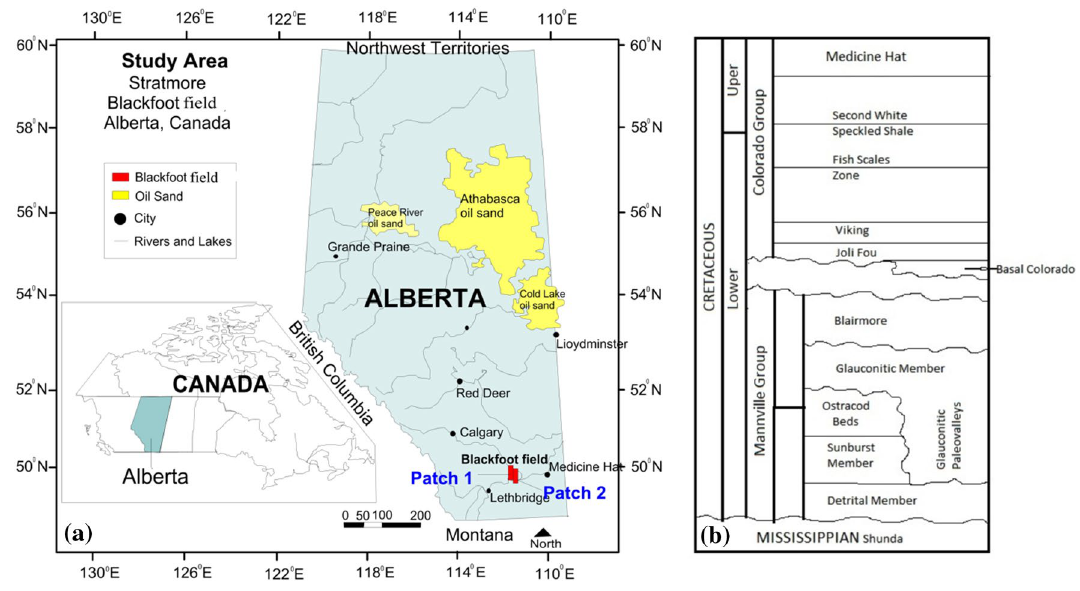
Fig. 1 a Location of Blackfoot field, Alberta, Canada and b stratigraphy of the Blackfoot field